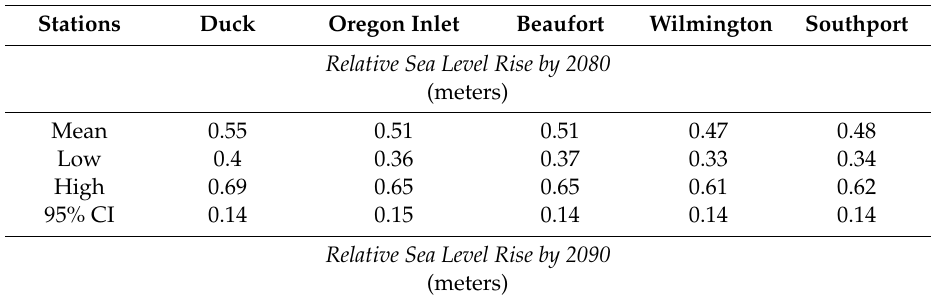
Table 2. Relative sea level rise for three time periods considering potential rates of sea level rise from the RCP 8.5 study (RCP 8.5 which is the highest greenhouse gas emission scenario, combined with estimated vertical land movement at the tidal gauges).